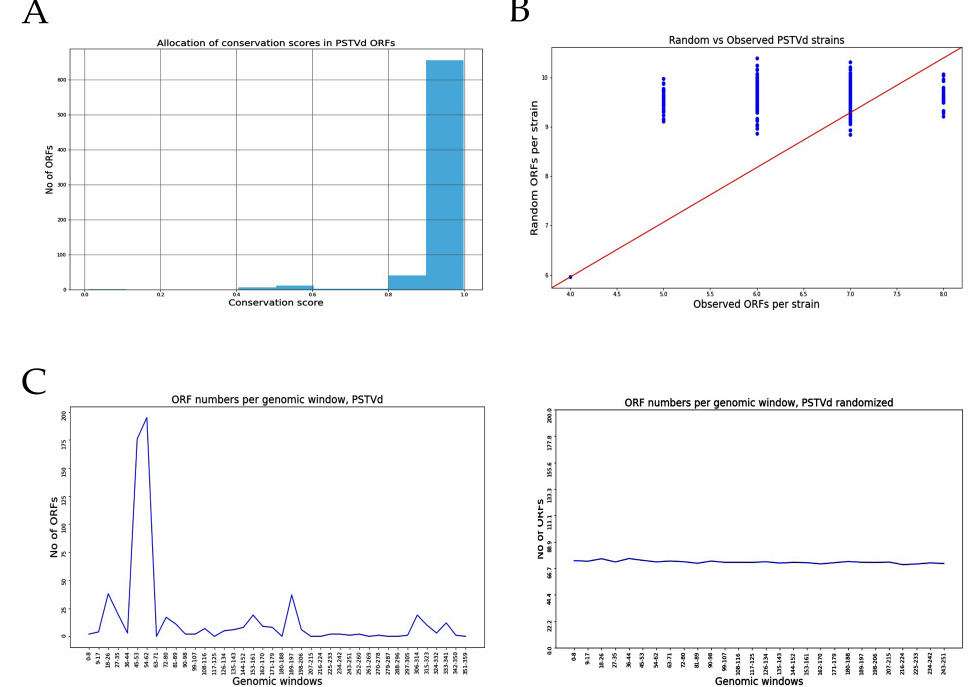
Figure 1. Identification of Possible ORFs in PSTVd. ( A ) Conservation rate in PSTVd isolates. ( B ) Comparison between artificially shuffled genome and real genome for PSTVd. ( C ) Presence of ‘hotspots’ in PSTVd